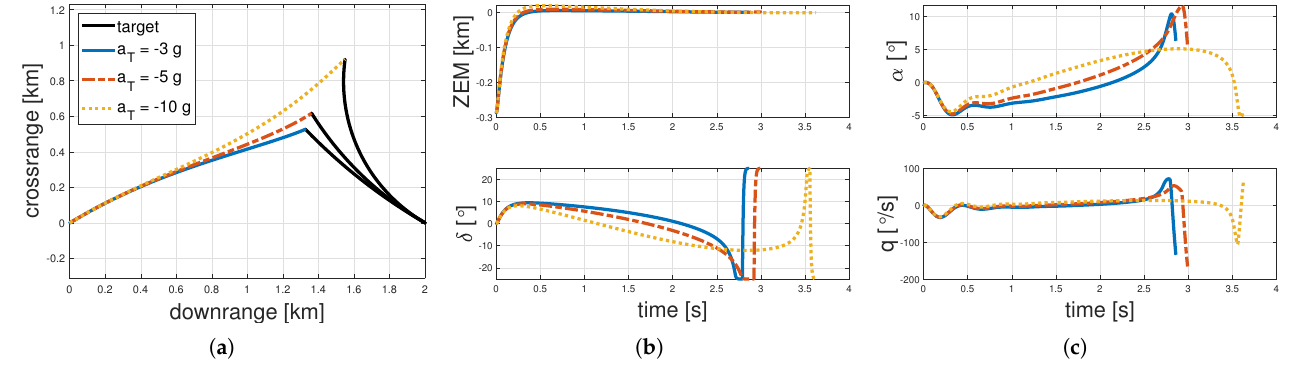
Figure 6. Simulation results of the integrated method under the tail-controlled missile model. ( a ) Flight trajectories. ( b ) ZEM and fin deflections. ( c ) State